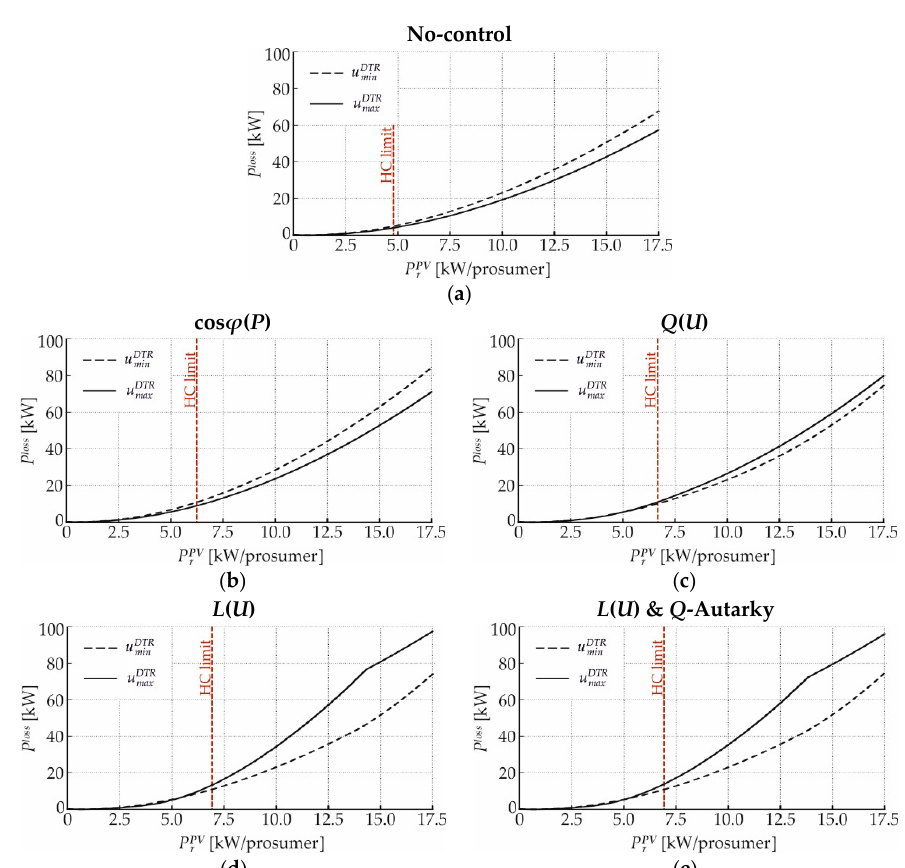
Figure 16. Grid losses of the branched cable test-feeder for the minimal and maximal DTR primary voltages and different control strategies: ( a ) no-control; ( b ) cos φ ( P )-control; ( c ) Q ( U )-control; ( d ) L ( U )-control; ( e ) L ( U )-control and Q -Autarkic prosumers.